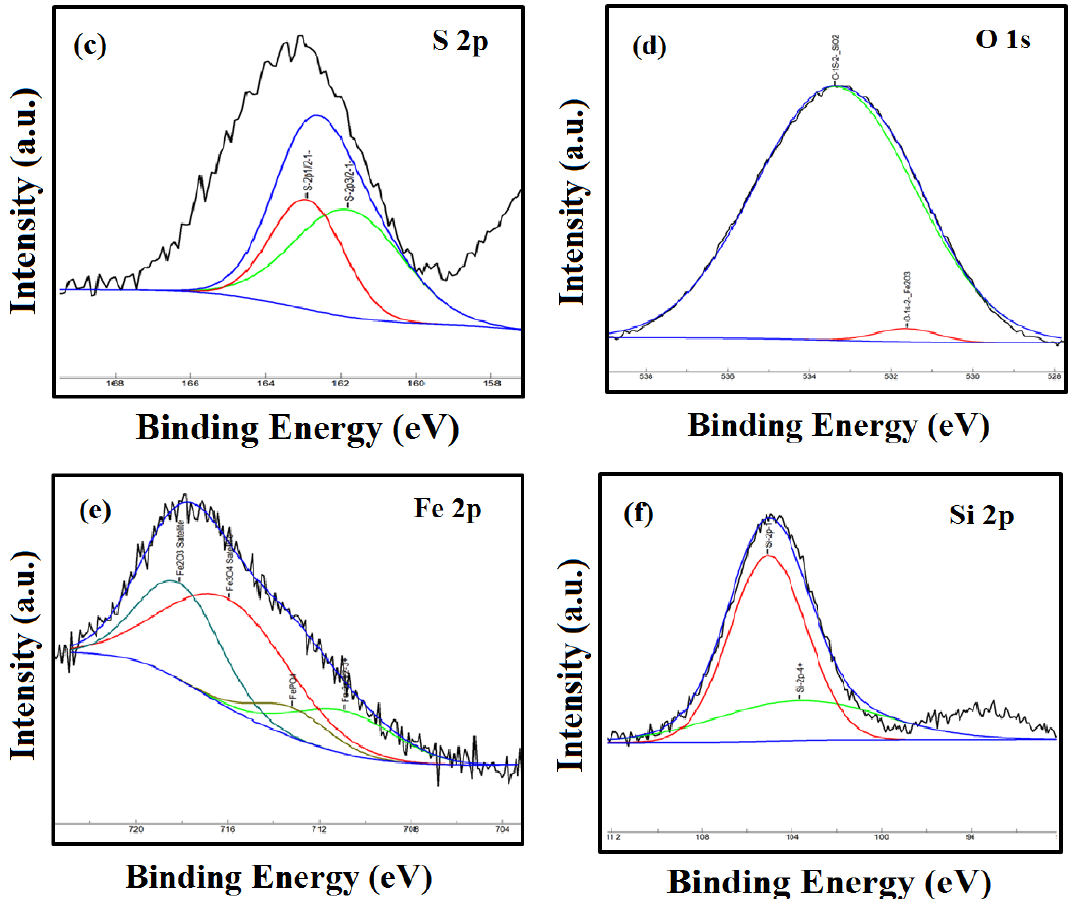
Figure 4. XPS ( a ) survey spectrum of SSF-15 wt % nanocomposite ( b – f ) Sn 3d, S 2p, O 1s, Fe 2p, and Si 2p.